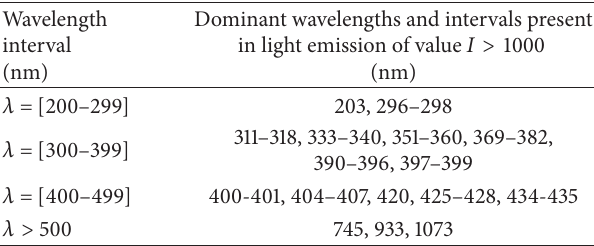
Table 2: Dominant wavelengths present in light emission of value 𝐼 > 1000 .